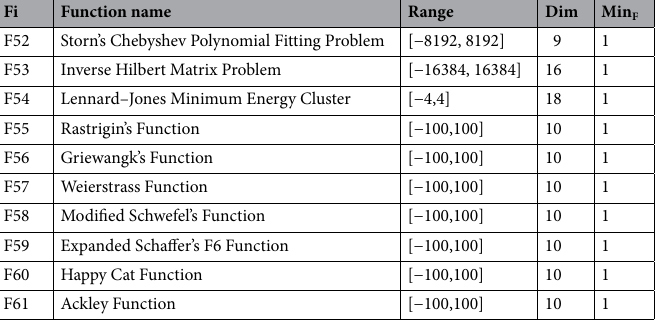
Table 10. CEC 2019